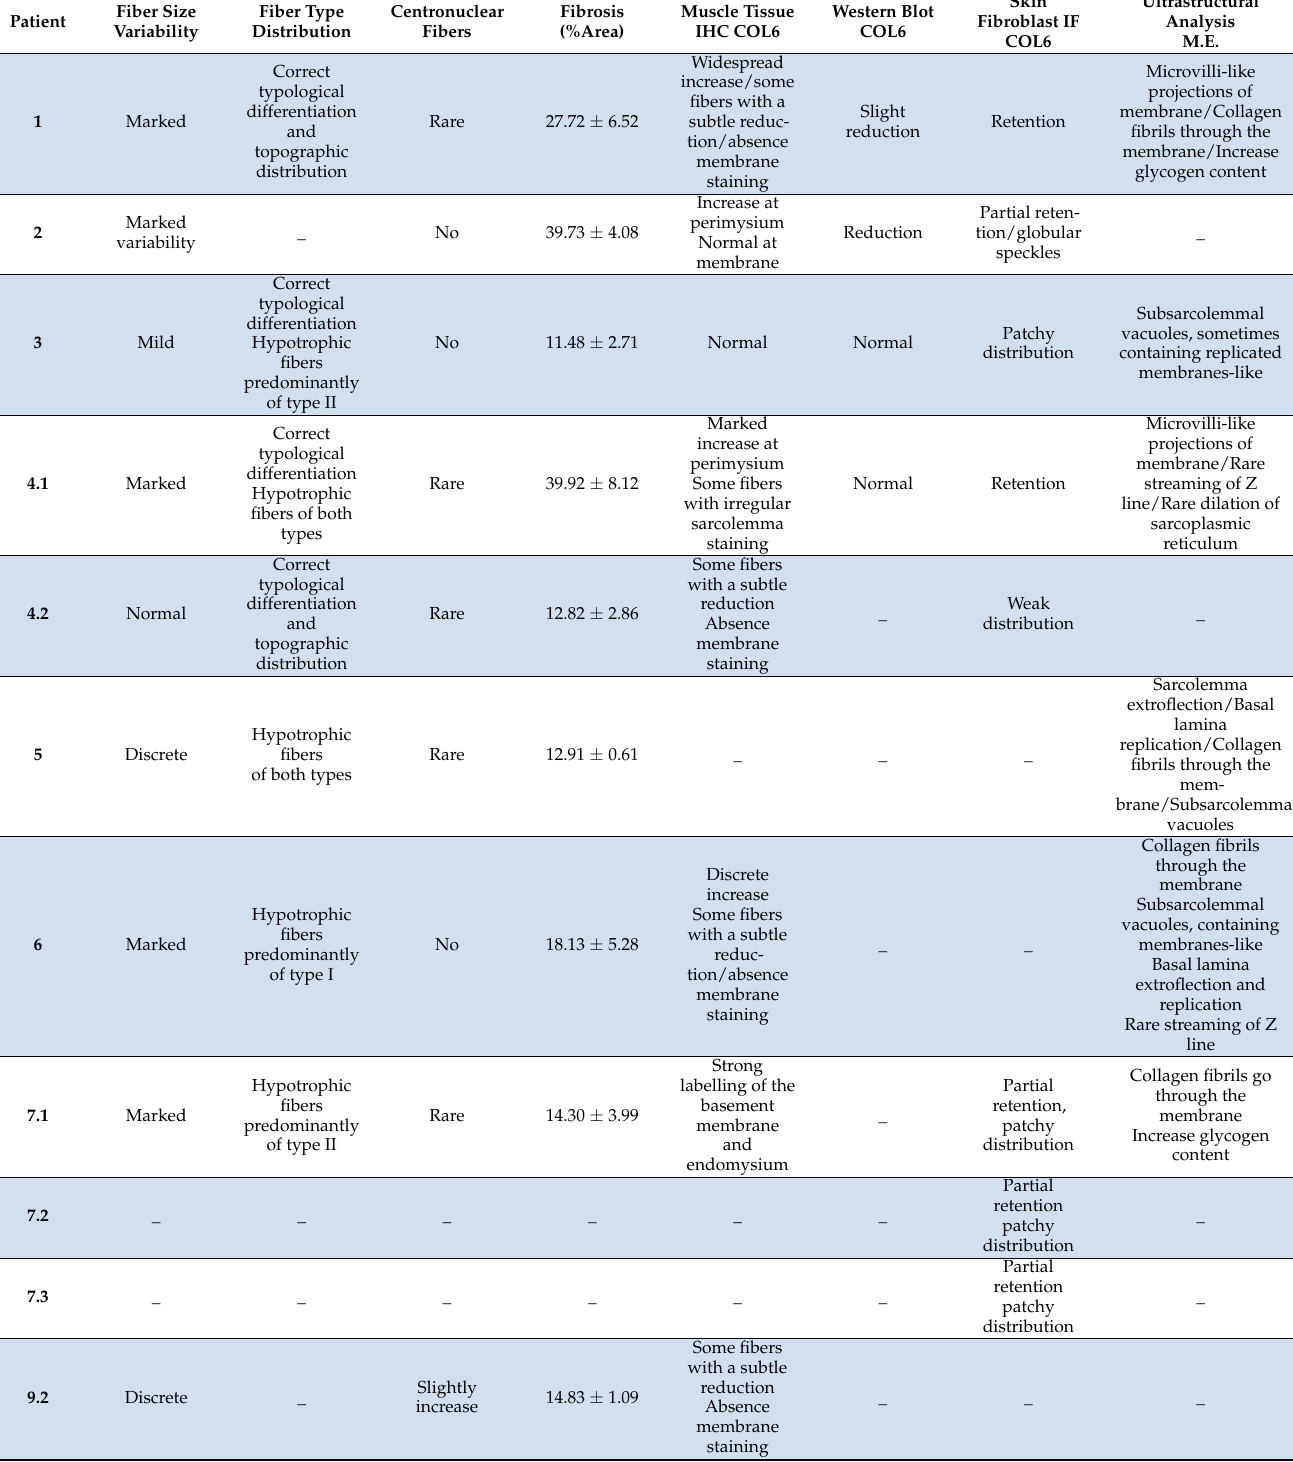
Table 3. Morphological, immunological and ultrastructural